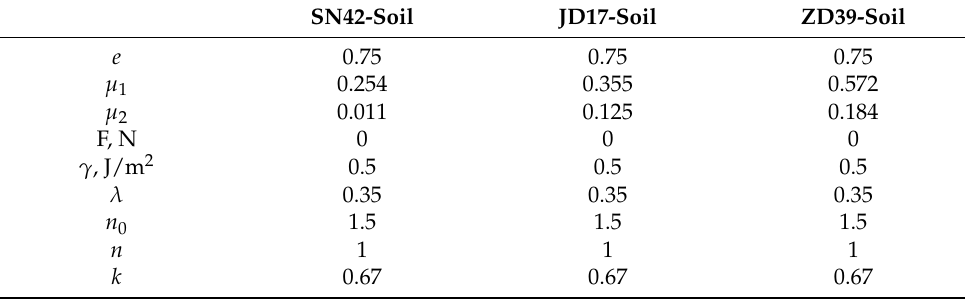
Table 9. Summary of simulation parameters between soybean and soil